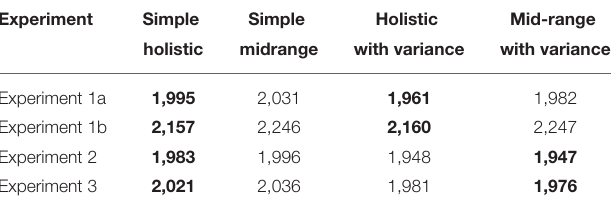
TABLE 1 | Average BIC value across participants for each model in each experiment (bold values mark the winning model at each level: simple/complex).